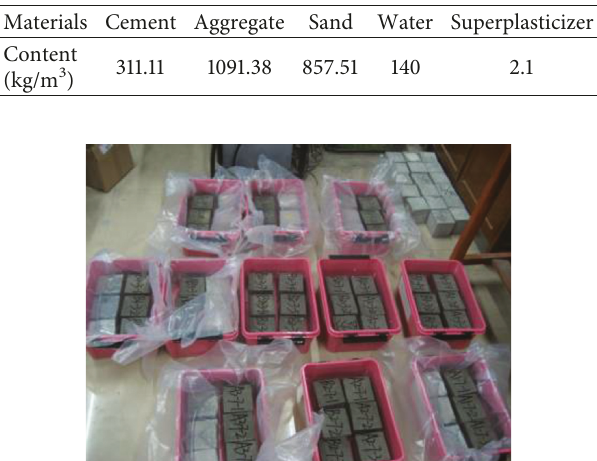
Table 1: Mix proportion of concrete specimens.